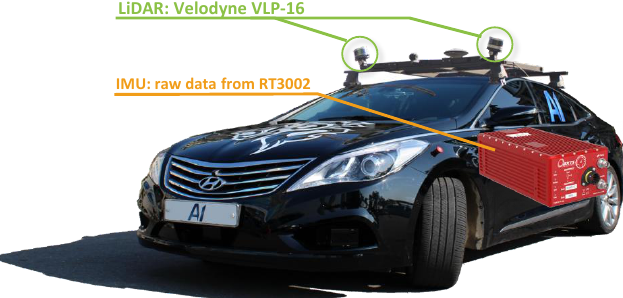
Figure 9. Test vehicle and sensor (LiDAR and positioning system)